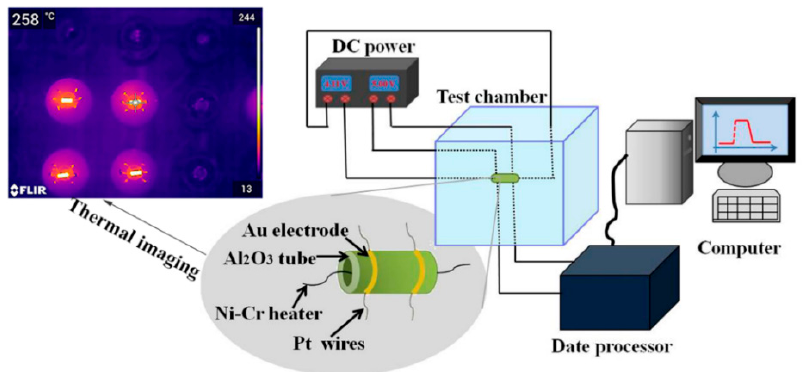
Figure 1. Schematic illustration of the experimental platform and thermal image of the device.